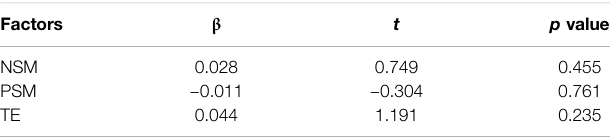
TABLE 14 | Factors excluded from the training multiple regression model (75% of data). Factors